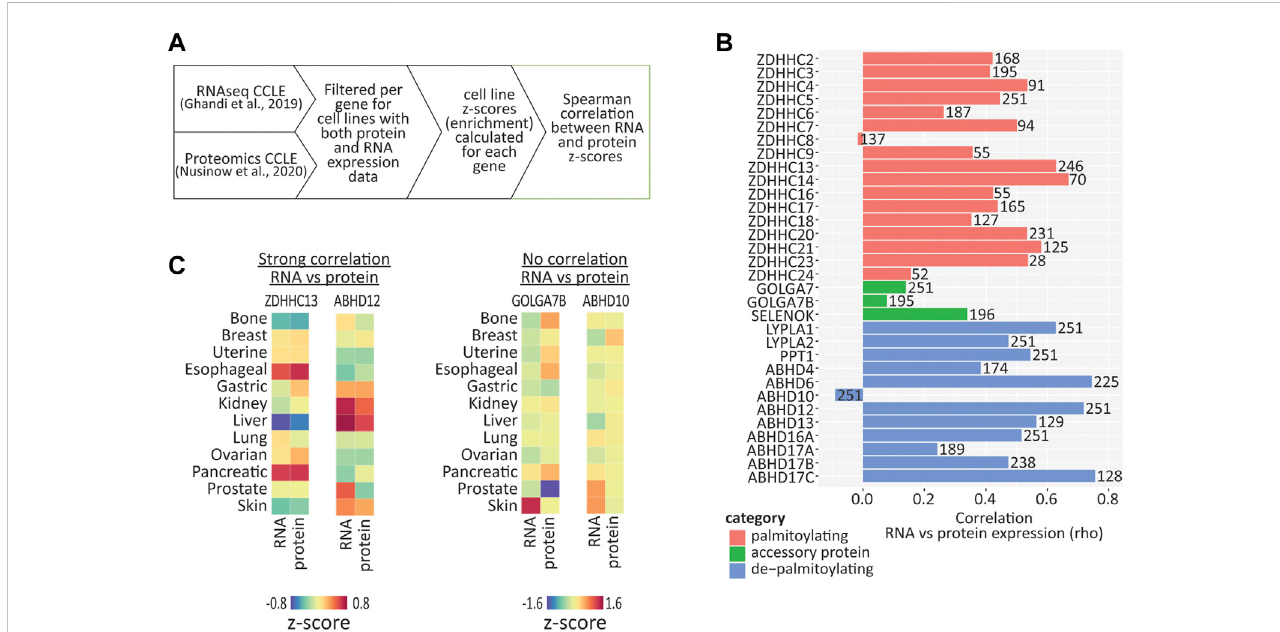
FIGURE 4 Correlation between RNA and protein expression using cancer cell line data. (A) Diagram illustrating how expression values were converted to z-scores and then correlation values calculated, using CCLE RNAseq and proteomic data. (B) Graph of Spearman correlation values calculated from expression z-scores across available CCLE cell lines, for RNA vs. protein. Number on each bar represents the number of cell lines (in which both RNA and protein were detected) used for each correlation calculation. (C) Heatmap showing enrichments of both RNA and protein across cancer type clusters for selected palmitoylating and depalmitoylating enzymes. Heatmap units: